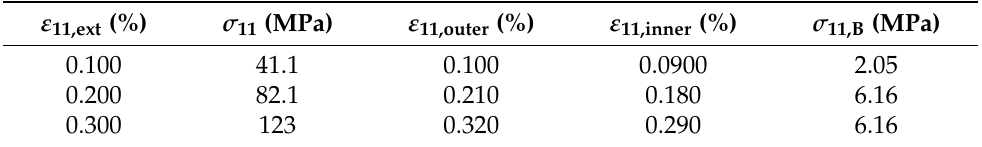
Table 2. Results of the strain-controlled tension test, in which the strain at the outer radius ε 11,outer and inner radius ε 11,inner in the gauge area are measured with strain gauges to determine the superimposed bending stress σ 11,B